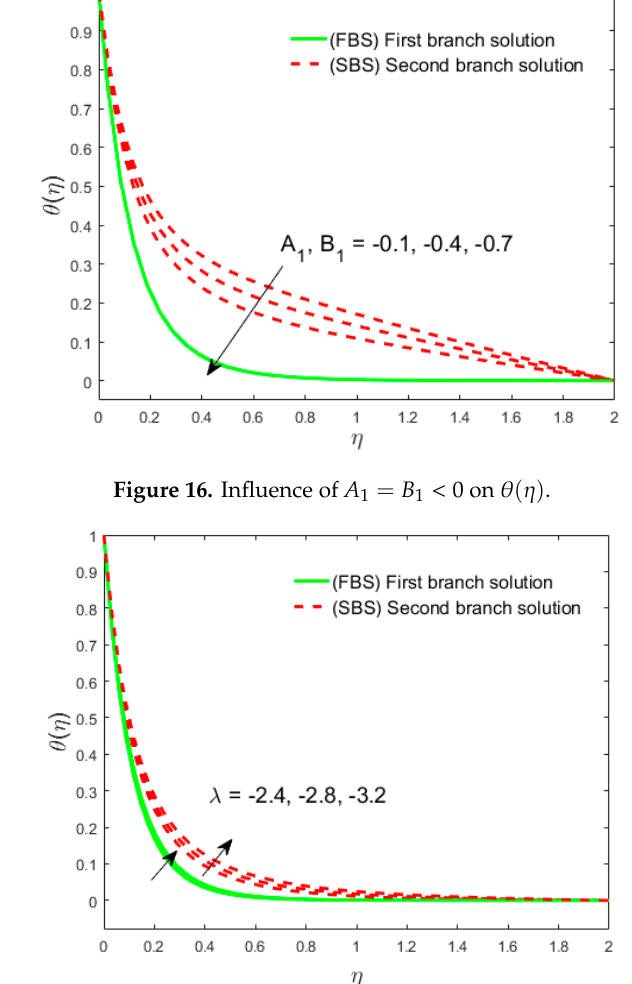
( ) θ η λ . Figure 17. Influence of λ on θ ( η ) on